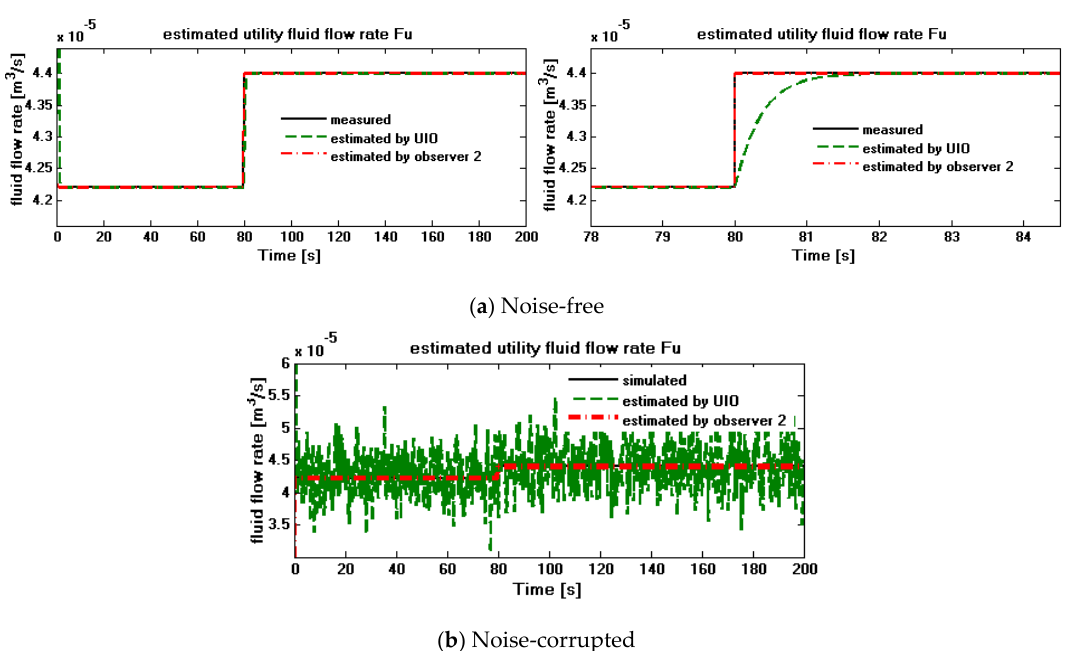
Figure 10. The computation and estimation of the utility fluid flow rate F u . The solid line is the computed value; the dashed line is estimated by the UIO; and the dashed, dotted line is estimated by Observer 2. ( a ) represents Noise-free case while ( b ) represents Noise-corrupted case.